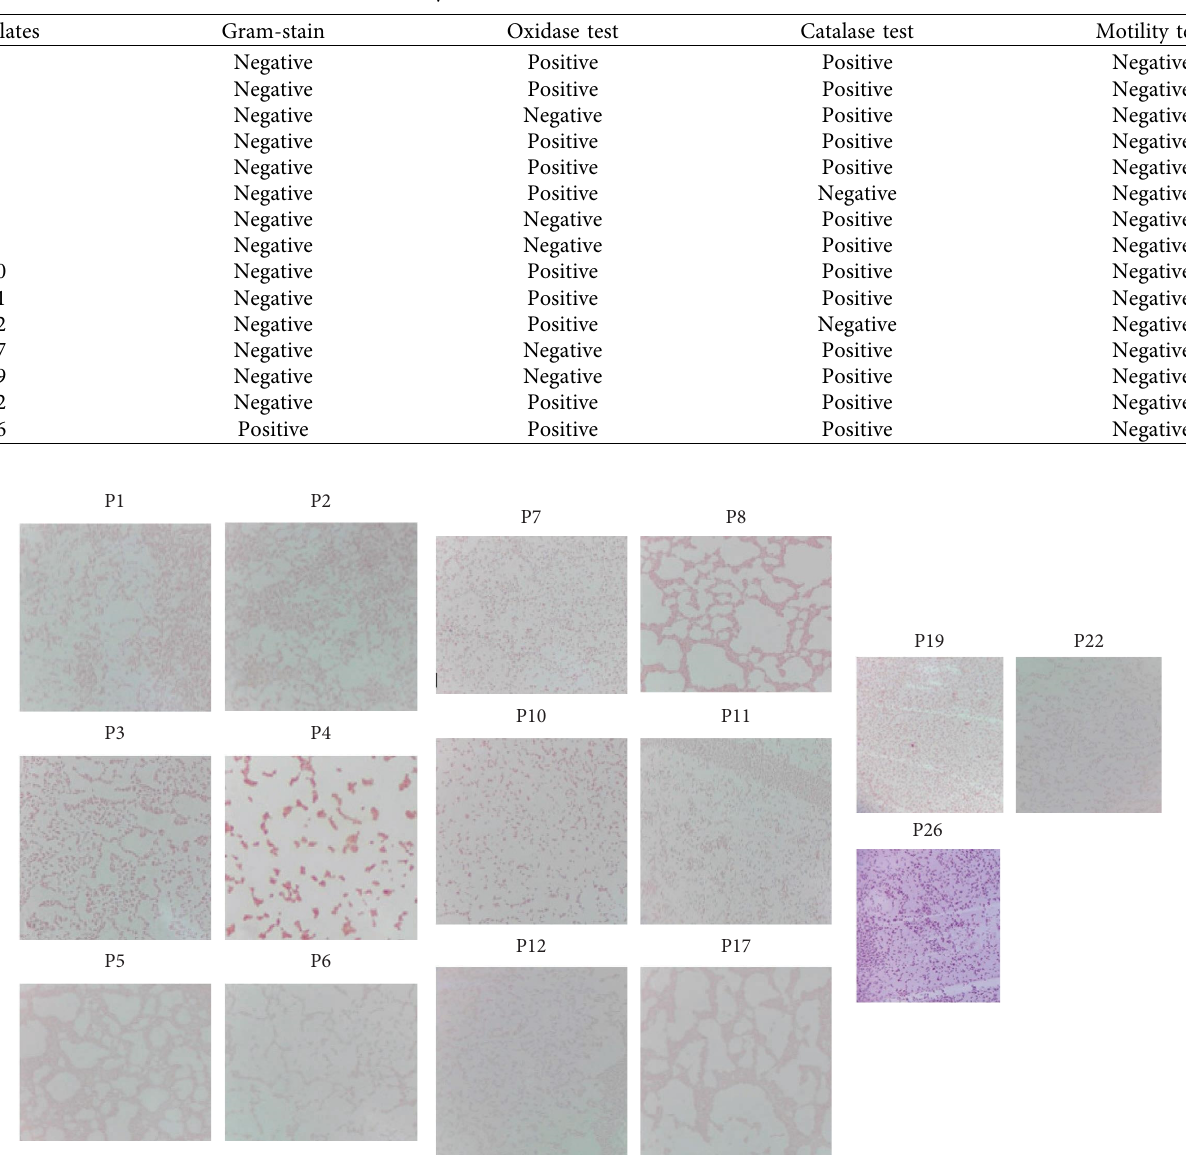
Table 4: Summary of biochemical test results of 15 isolated bacteria.